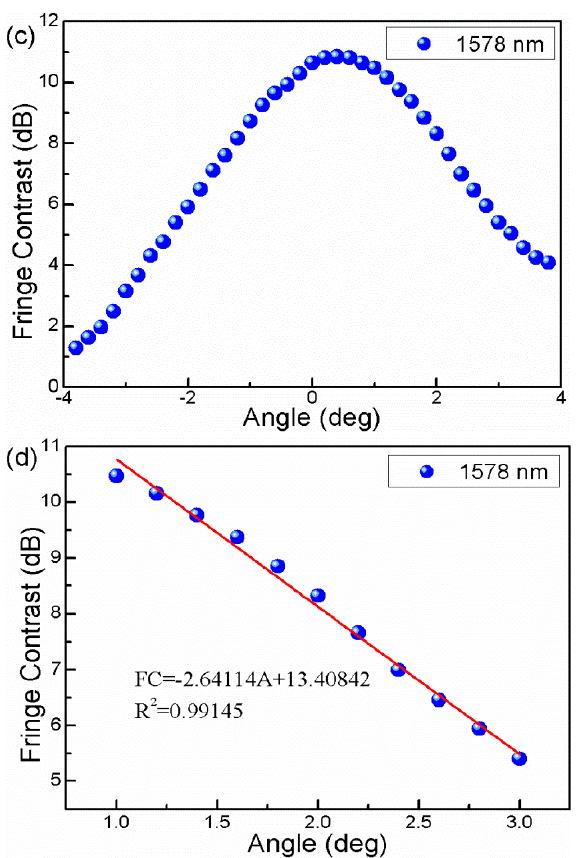
Figure 5. ( a ) Fringe contrast variation of interference valley near1576 nm; ( b ) Fringe contrast response linear fitting from 1° to 3° of 1576 nm valley; ( c ) Fringe contrast variation of interference valley near1578 nm; ( d ) Fringe contrast response linear fitting from 1° to 3° of 1578 nm valley.